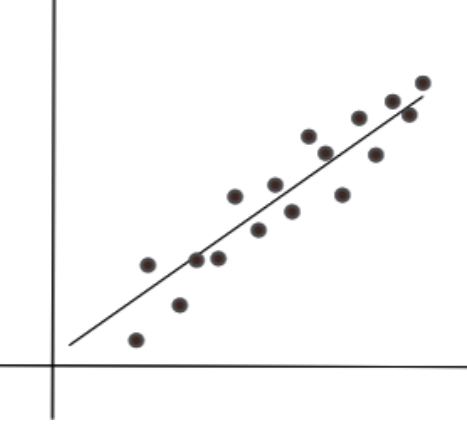
Figure 1. Linear regression example.